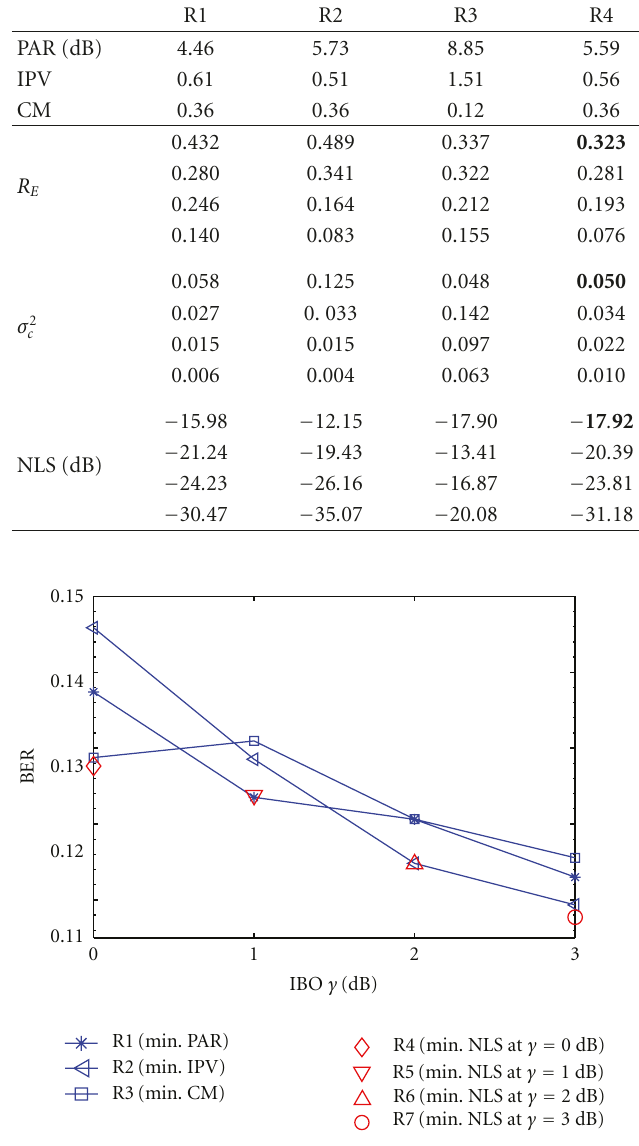
Figure 4: BER of (16) computed for R1–R7 versus IBO levels.